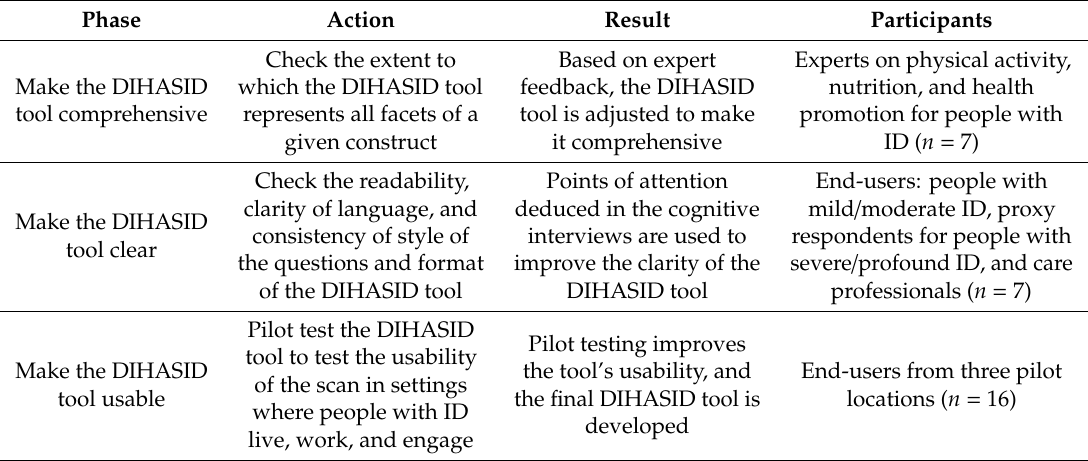
Table 1. Development of the DIHASID tool: phases, action, results, and participants. ID: intellectual